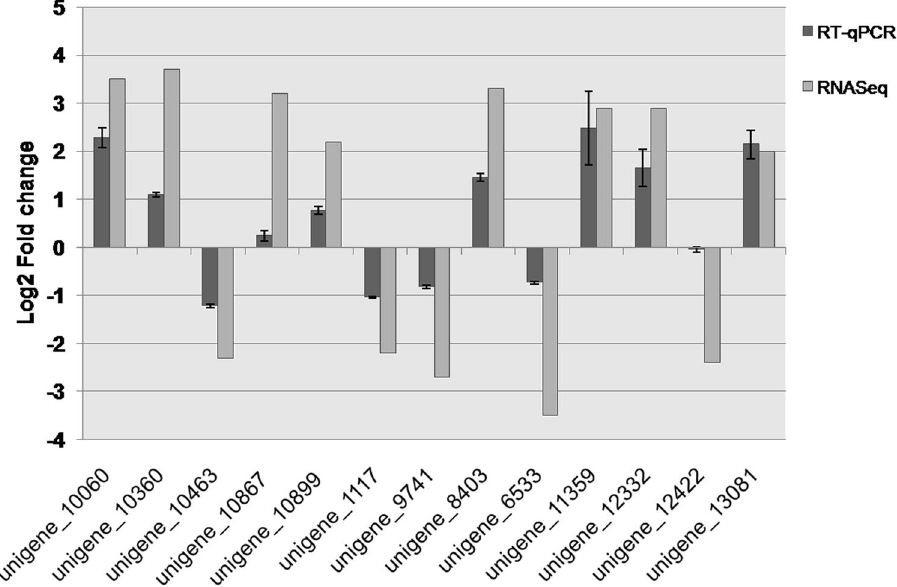
Figure 7. Validation of RNA-Seq data using RT-qPCR. Thirteen representative genes were selected to validate the RNA-Seq data by RT-qPCR. The dark grey bars represent mean values of log2-fold change obtained from three replicates of RT-qPCR with error bars representing ± SD and the light grey bars represent the RNA-Seq